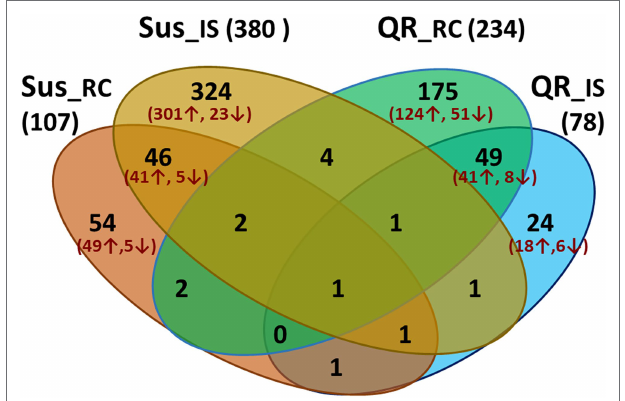
FIGURE 2 | Venn diagram showing numbers of differentially expressed genes (DEGs) during western hemlock– H. occidentale interaction. DEGs were identified by transcriptome comparisons between controls (mock-inoculation) and seedlings inoculated by fungus with proportional fold changes ≥ 2 at FDR-corrected p < 0.05. Four comparisons are included as susceptible seedlings (Sus), or seedlings with quantitative resistance (QR) versus controls at the inoculation sites (IS) and root collar (RC),